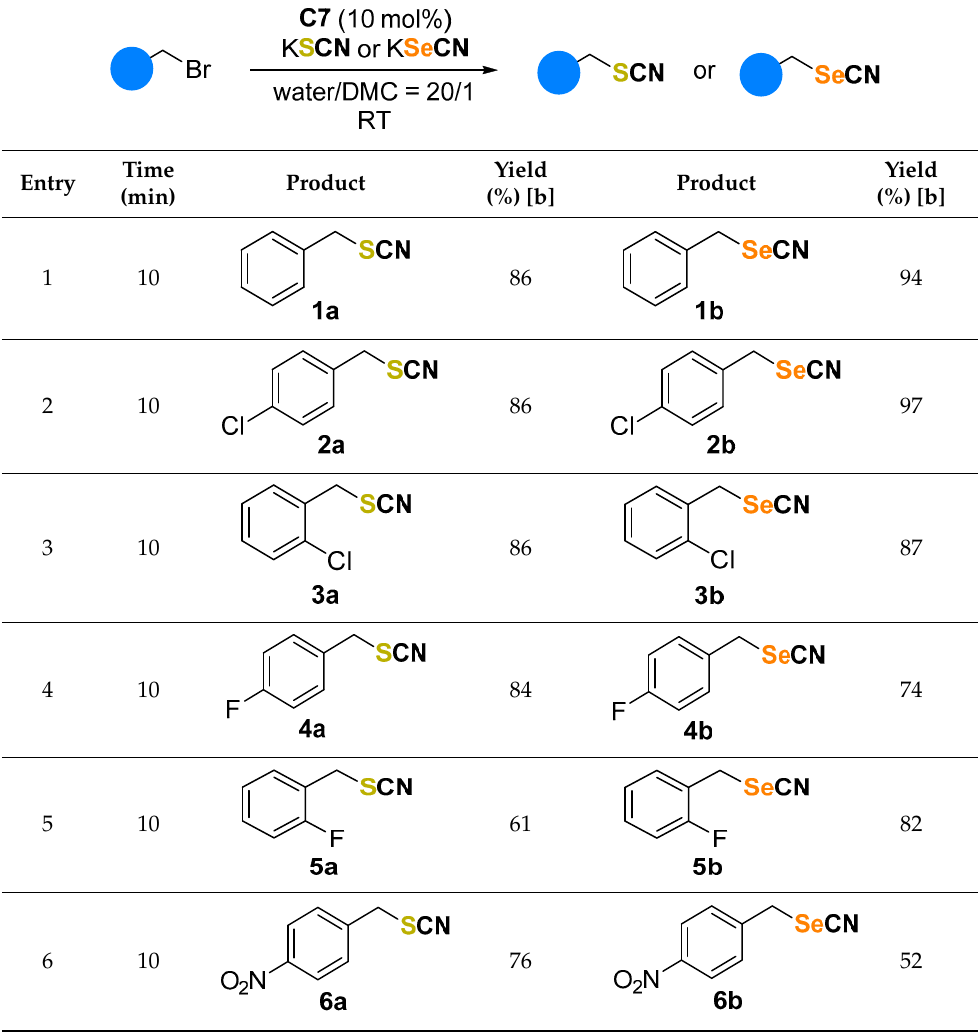
Molecules 2023 , 28 , x FOR PEER